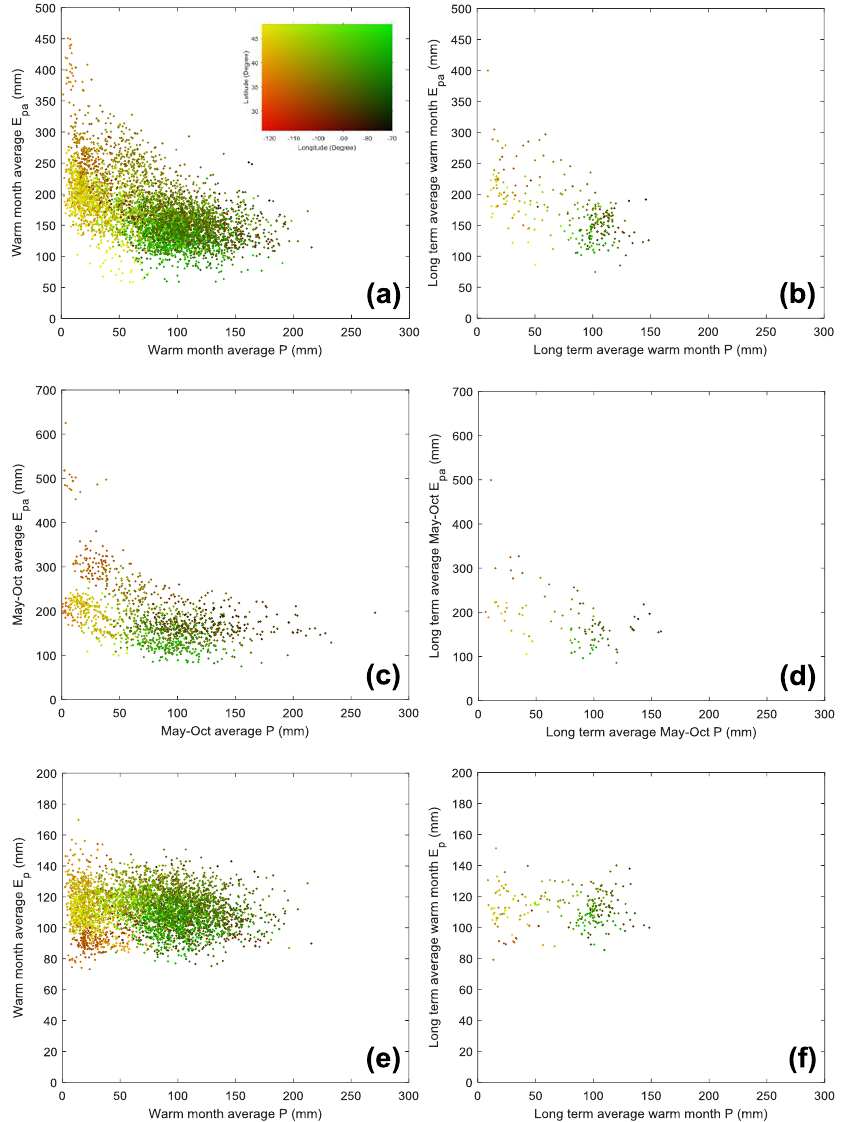
Figure 5. P vs. E pa at 259 weather stations in the US for the period 1984 to 2015 for (a) warm-season data ( N = 5312) and (b) long-term annually averaged warm-season data ( N = 259). The data points are color-coded based on their latitudes and longitudes. P vs. E pa at 93 weather stations in the US for the period 1984 to 2001 using the homogenized pan evaporation dataset for (c) the warm period May–October in each year ( N = 1214), and (d) long-term annual average warm period May–October data ( N = 93). P vs. E p at the 259 weather stations for the period of 1984 to 2006 for (e) warm-season data ( N = 5312) and (f) long-term annual average warm-season data ( N =